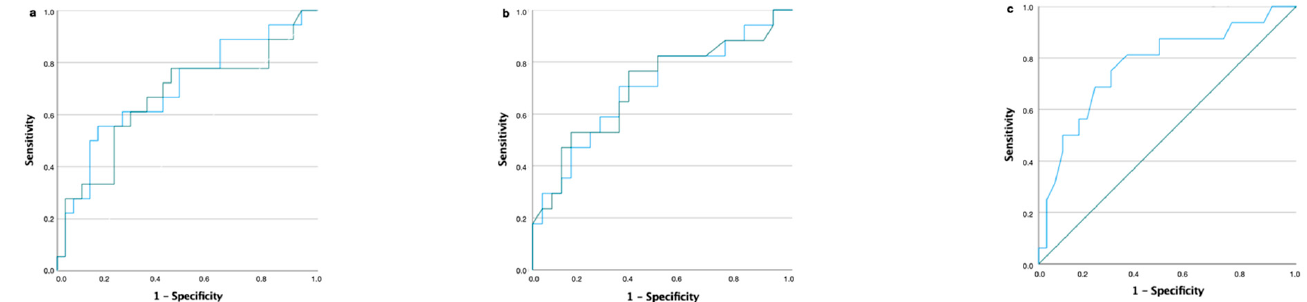
Figure 3. Receiver operating characteristic curves for endothelin-1 and nitric oxide metabolites for the prediction of postoperative complications. ( a ) AUC for ET-1 before surgery (blue line)